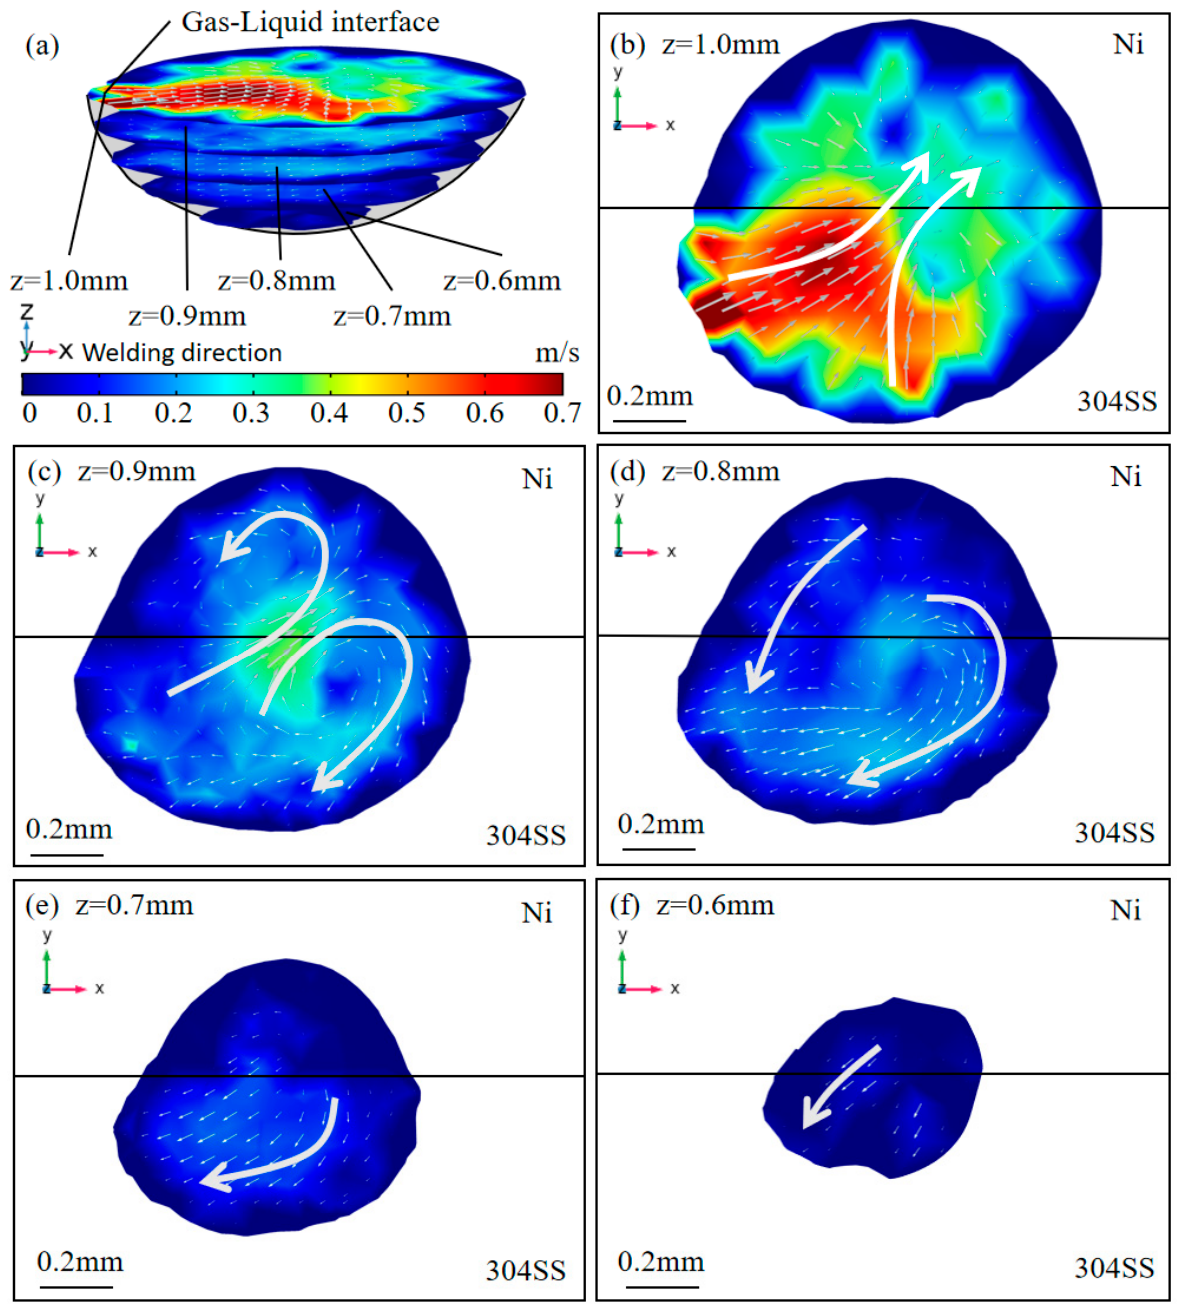
Figure 14. Fluid flow of the molten pool in the AMO for different X–Y sections. ( a ) Overview of sections in the molten pool: ( b ) z = 1.0 mm; ( c ) z = 0.9 mm; ( d ) z = 0.8 mm; ( e ) z = 0.7 mm; ( f ) z = 0.6 mm.